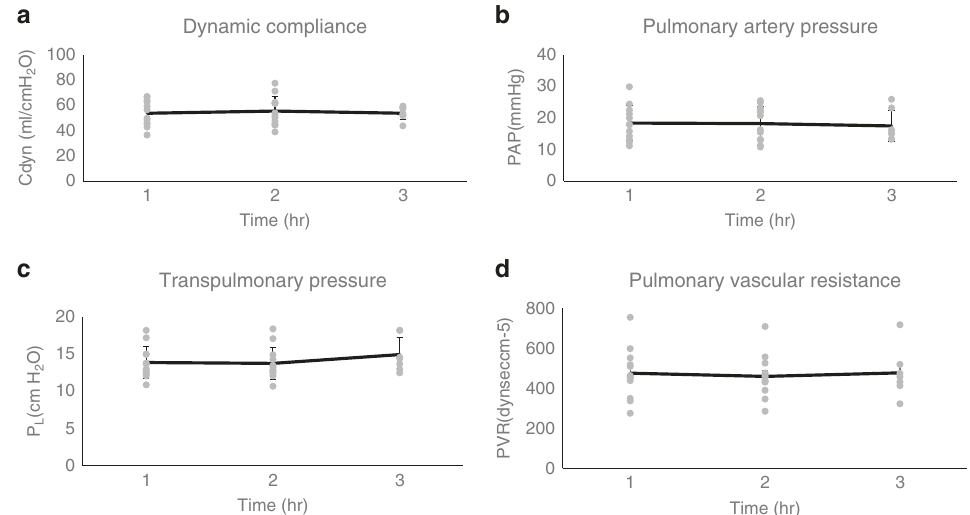
Fig. 1 NPV-ESLP demonstrated stable hemodynamic parameters over the course of perfusion. Dynamic compliance (Cdyn) ( a ), pulmonary artery pressure (PAP) ( b ), transpulmonary pressure ( P L ) ( c ), and pulmonary vascular resistance (PVR) ( d ) over time. Results are expressed as mean ± SE (n T1 = 12, n T2 = 12, n T3 = 5). Table 2 Recipient demographic details and clinical outcomes*.